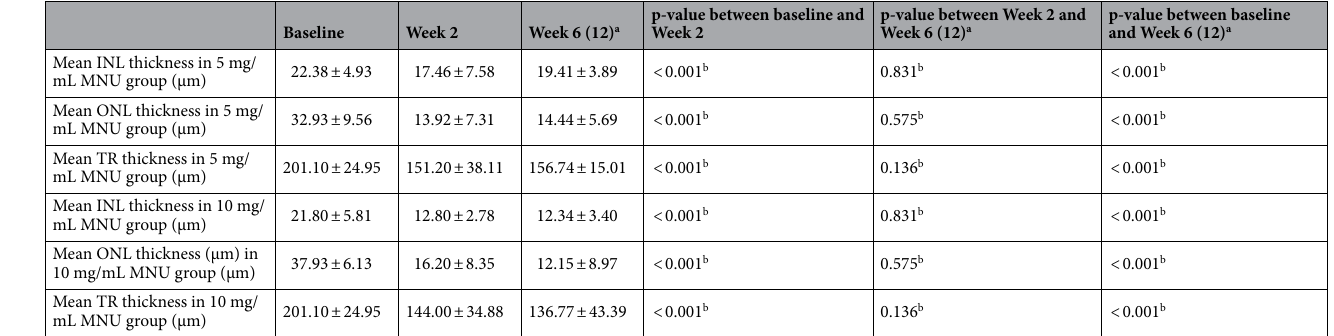
Table 2. Optical coherence tomography findings of the 5 mg/mL MNU group (n = 10) and 10 mg/mL MNU groups (n = 13). INL inner nuclear layer, MNU N -methyl- N -nitrosourea, ONL outer nuclear layer, POD postoperative day, TR total retinal thickness. a At week 12 in 10 mg/mL MNU group. b Wilcoxon-signed ranked